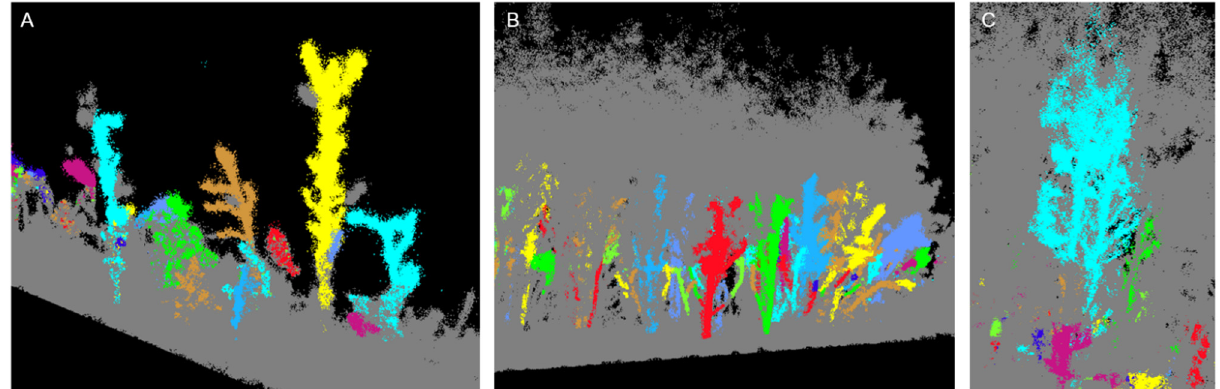
Figure 6. Examples of point clouds shown in the LiDAR 360 software following point cloud seg- mentation; grey represents points that were unassigned to a tree, whereas coloured areas denote points assigned to an individual tree in a poorly vegetated ( A ) and densely vegetated ( B ) seismic line; ( C ) shows a tree where a portion of the canopy was successfully identified following segmen- tation.